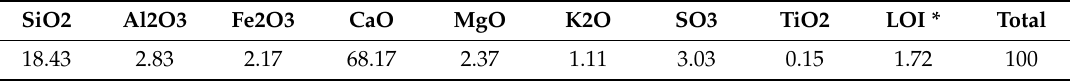
Table 1. Chemical composition of ordinary Portland cement.